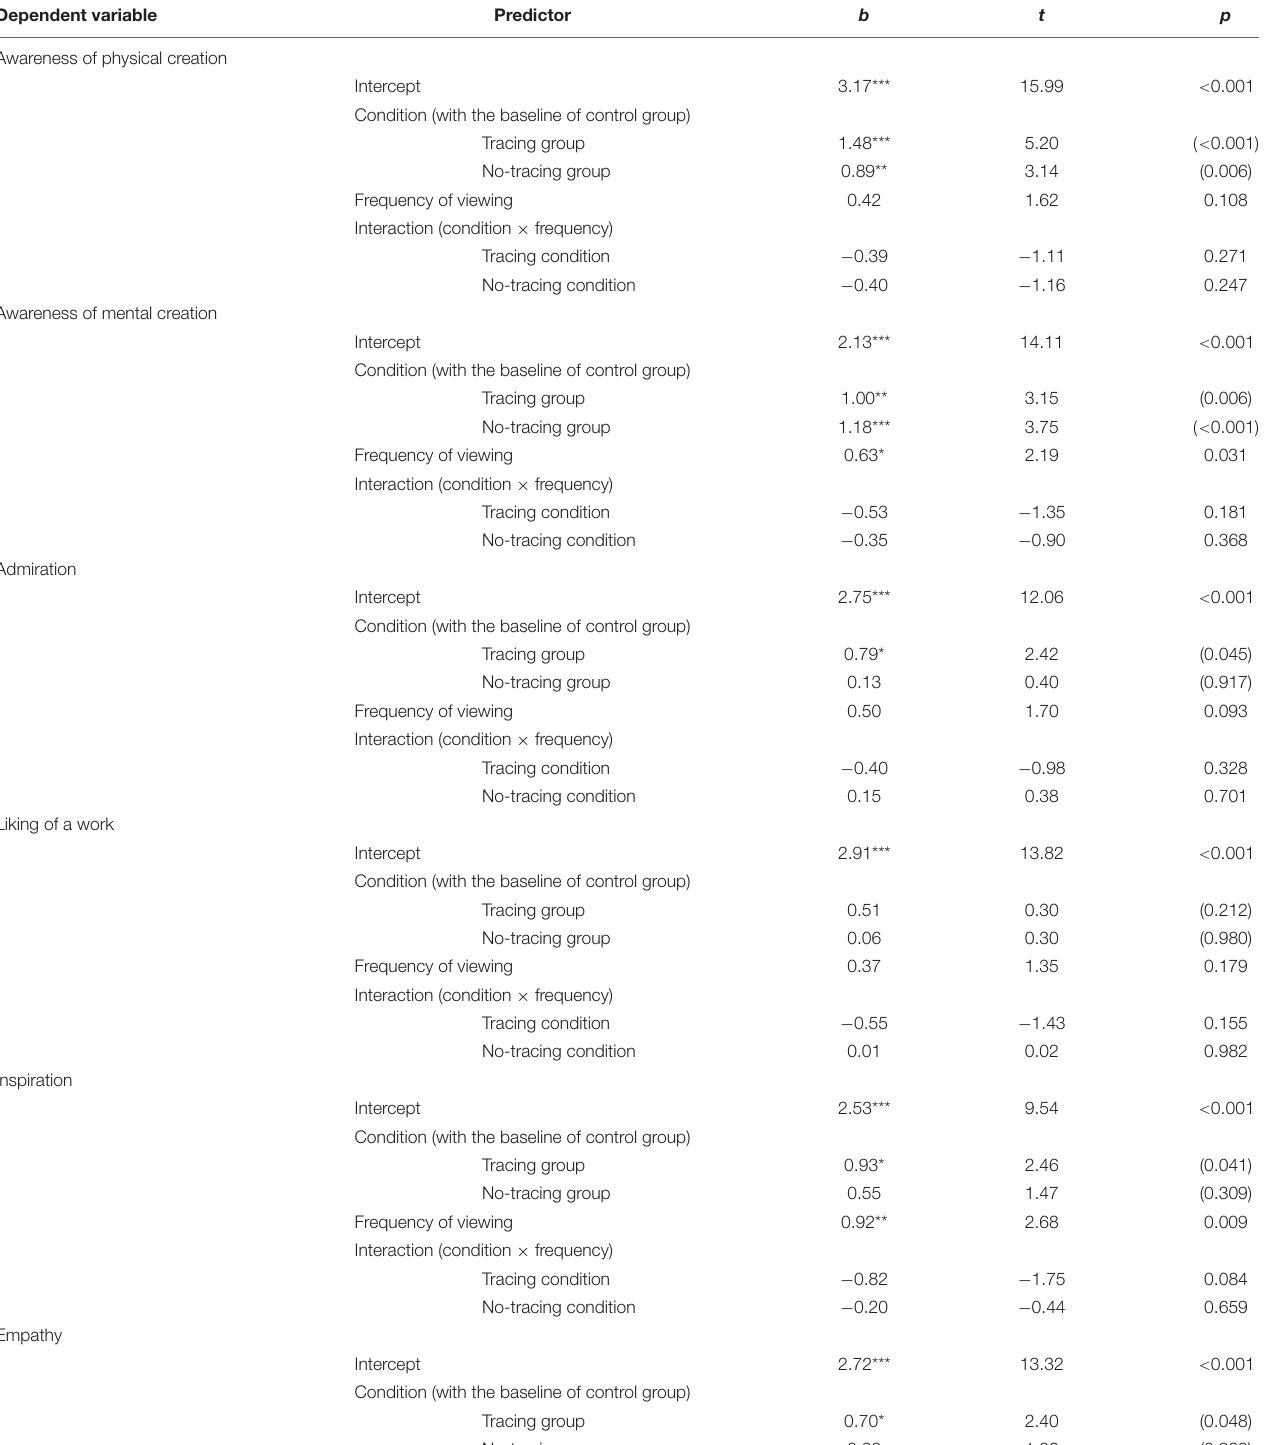
TABLE 2 | Multiple regression analyses in Study